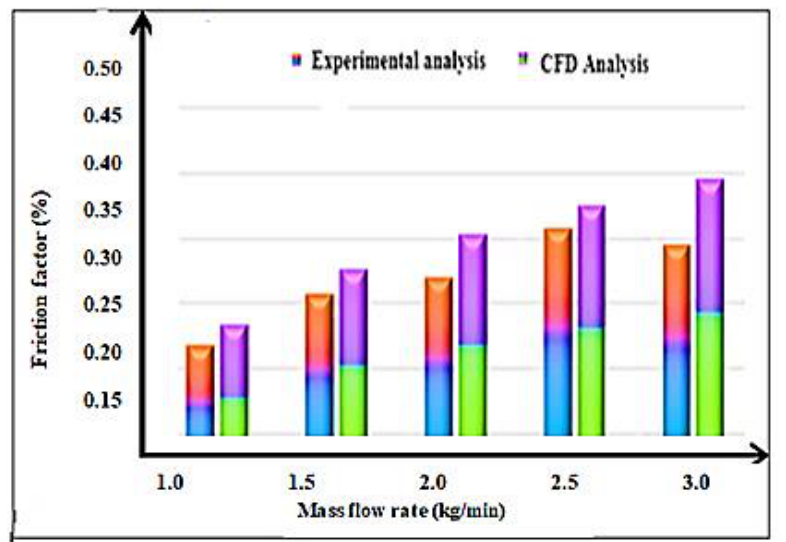
Figure 7. An evaluation of the friction Figure 7 . An evaluation of the friction factor .